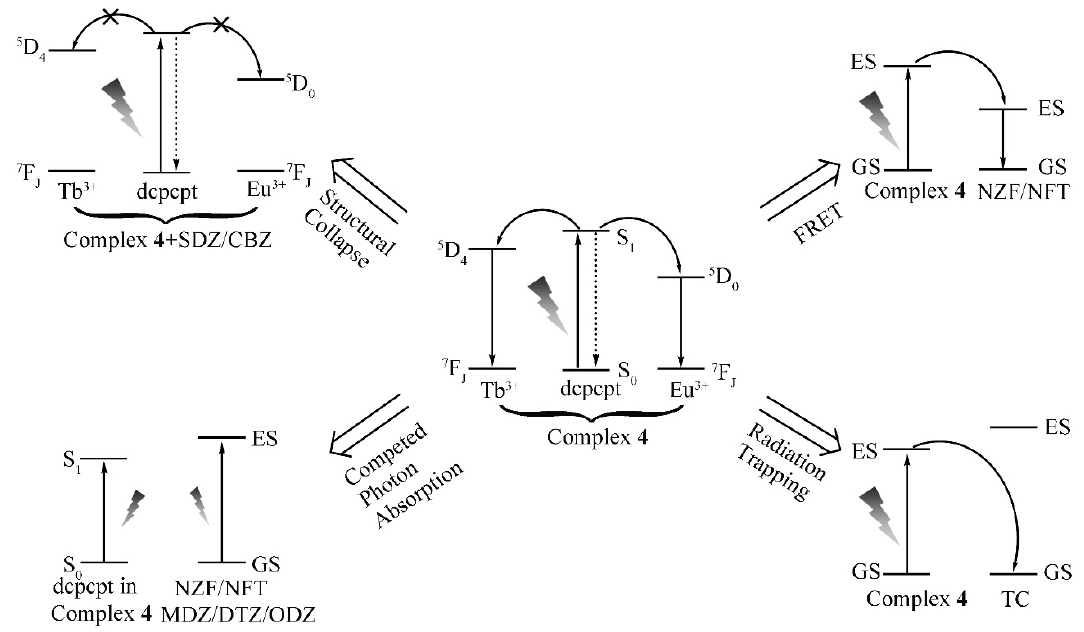
Scheme 1. Effect of antibiotics on the antenna effect of complex 4 .